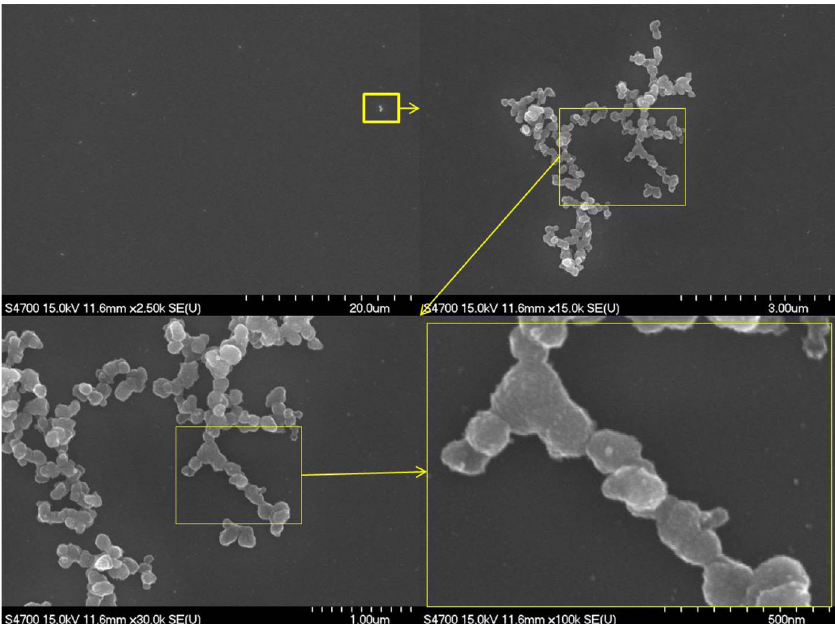
FIG. 5. Sparsely distributed granules were observed on the sample surfaces. They reside on a clear flat surface and their density is low.